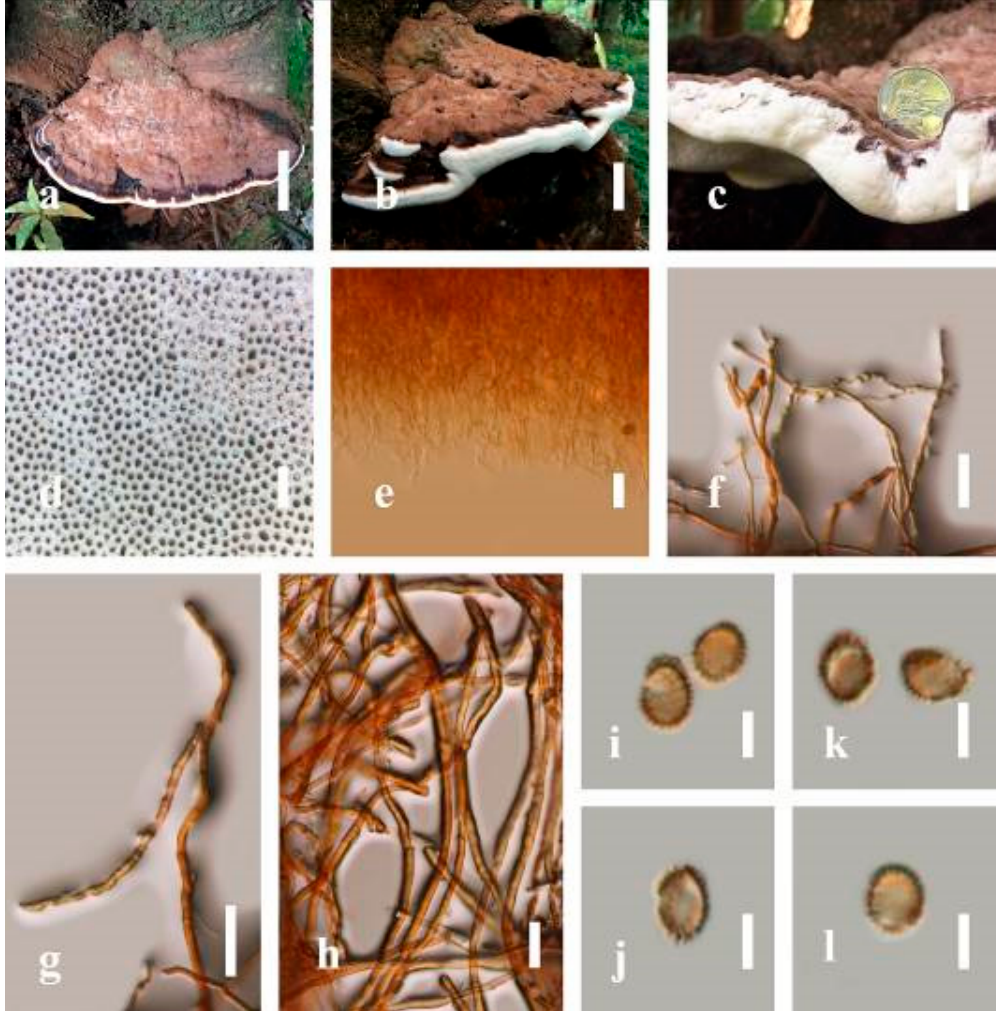
Figure 5. Morphology of Ganoderma australe (HKAS 97397): ( a , b ) mature basidiomes; ( c ) margin; ( d ) pore characteristics; ( e ) mycelia of tube layers; ( f – h ) context hyphae as seen in Melzer’s reagent; ( i – l ) basidiospores. Scale bars: ( a ) = 5 cm, ( b ) = 3 cm, c = 1 cm, d = 500 μ m, e = 20 μ m, f = 20 μ m, g,h = 10 μ m, i–l = 5 μ m. Ganoderma calidophilum J.D. Zhao, L.W. Hsu and X.Q. Zhang, Acta Mycologica Sinica 19: 270 (1979) (Figure 6) Facesoffungi number: FoF 06244